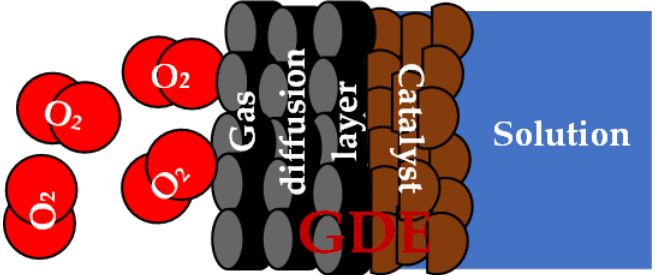
Figure 8. Schematic of a gas diffusion electrode adapted from [166].